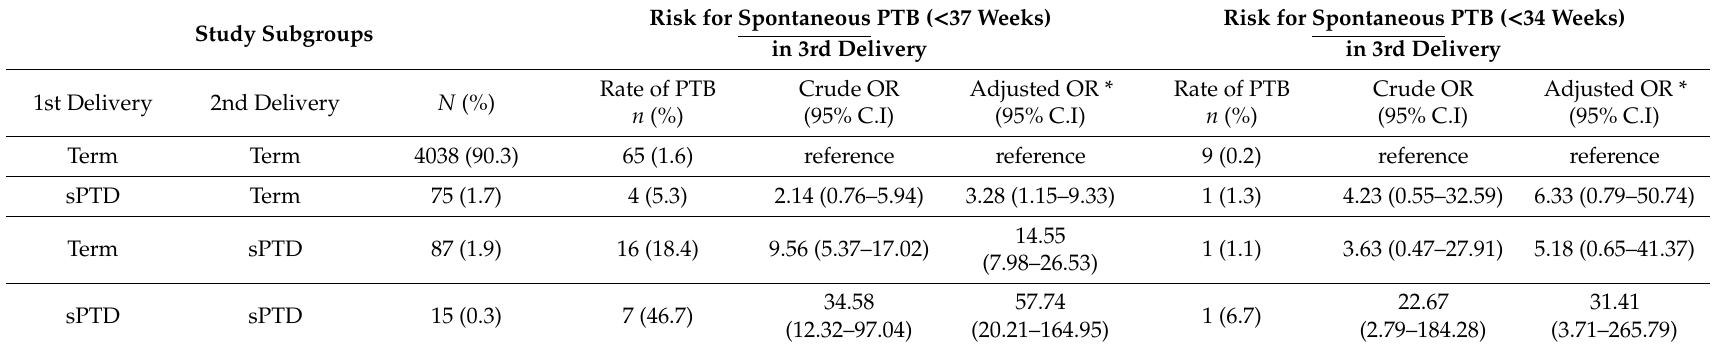
Table 3. The risk for spontaneous preterm birth in the third delivery stratified by history of spontaneous preterm births. Study Subgroups